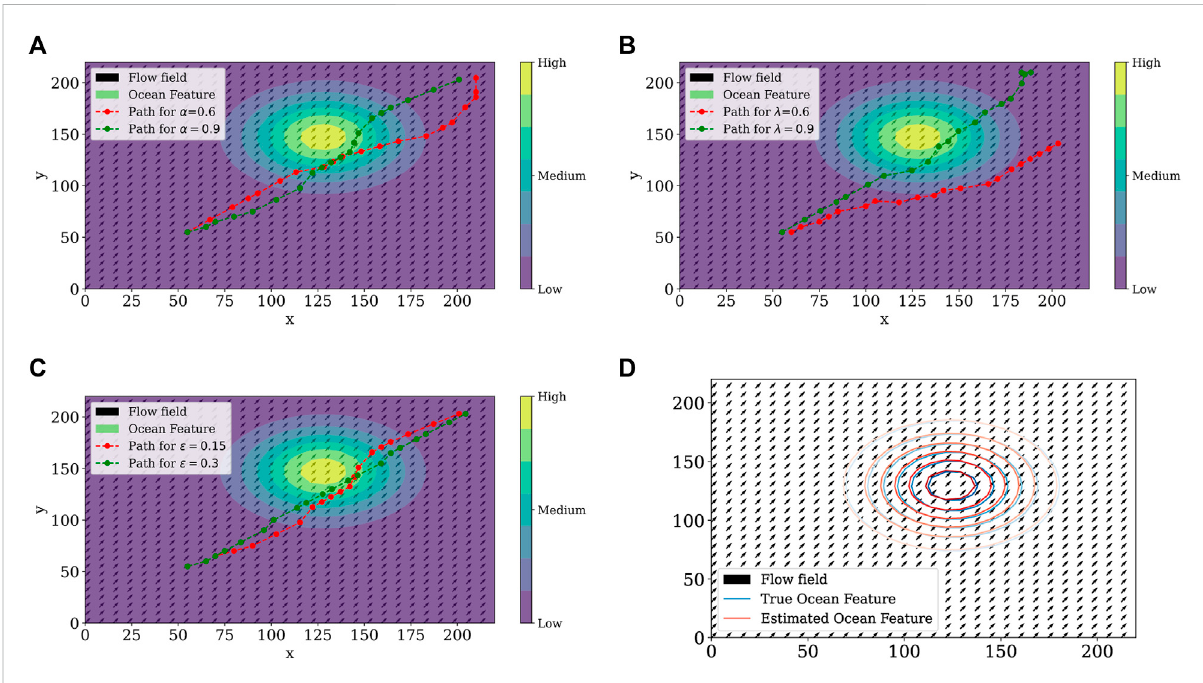
FIGURE 4 Agent path with the variation of step size α (A) , trace decay rate λ (B) , and ε -greedy parameter (C) . (D) Difference between the true and the estimated ocean